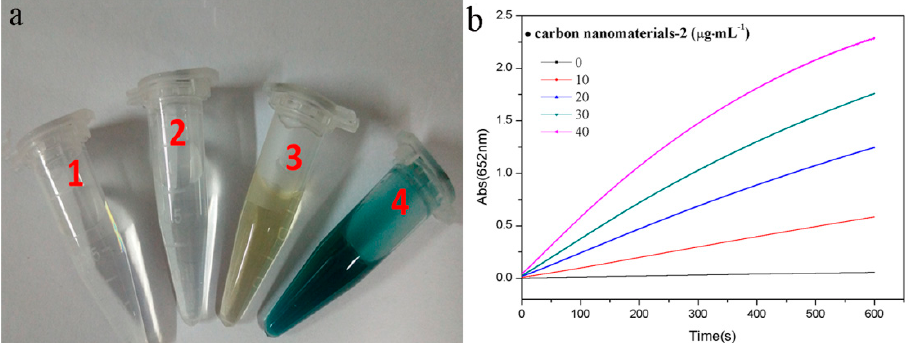
Figure 4. ( a ) Typical photographs of 1 mL of 800 µM 3,3’,5,5’-tetramethylbenzidine (TMB) reaction solutions oxidized by Carbon nanomaterials-2 in the presence of H 2 O 2 after 5 min incubation at 35 °C in 25 mM phosphate buffer (pH 4.0): (1) 800 µM TMB; (2) 50 mM H 2 O 2 and 800 µM TMB; (3) 800 µM TMB and 40 µg·mL − 1 Carbon nanomaterials-2; (4) 50 mM H 2 O 2 , 800 µM TMB and 40 µg·mL − 1 Carbon nanomaterials-2. ( b ) The time-dependent absorbance changes at 652 nm in the absence or presence of Carbon nanomaterials-2 in 25 mM phosphate buffer (pH 4.0) at 35 °C. The profile of the time-dependent absorbance were acquired with an UV-3600 UV-vis-NIR spectrometer (Shimadzu, Kyoto,